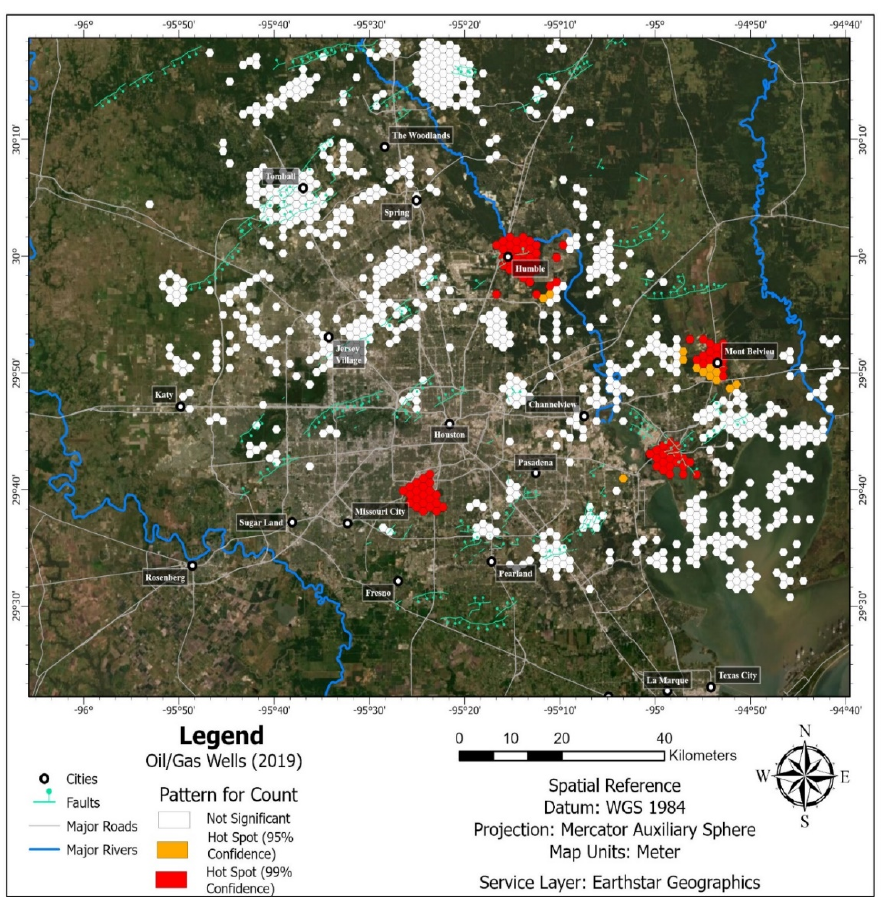
Figure 6. Optimized hot spot results for the oil/gas well count in Houston and surrounding areas. A neighborhood distance of 2000 m was used.